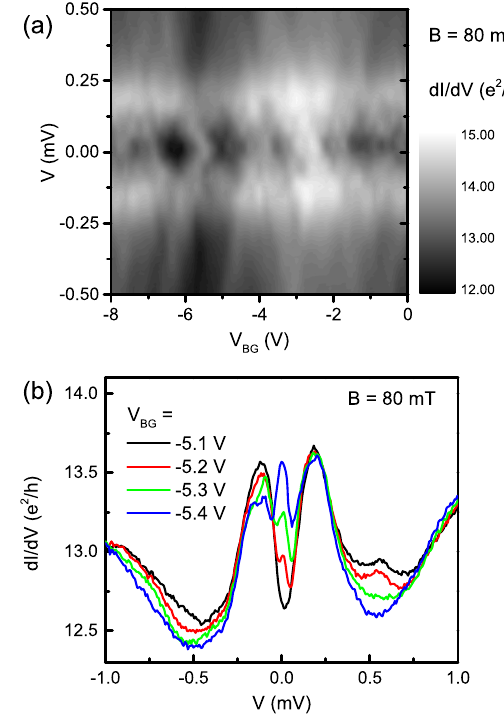
FIG. 6. (a) Color plot of dI=dV versus source-drain bias V and backgate bias V at B ¼ 80 mT, with intricate low-energy BG resonances. (b) Example conductance traces at 80 mT, showing FIG. 7. (a) Magnetic-field evolution of zero-bias peak at ¼ − 5 . 4 V. V ¼ − 5 . 4 V. Peak appears beyond 65 mT and remains for evolution of zero-bias peak near V BG BG up to B ¼ 120 mT. No such peak is present at zero field or when an in-plane field is applied perpendicular to current flow. (b) Temperature dependence of zero-bias peak at 80 mT. Thermal fluctuations cause the peak to broaden and merge with back-